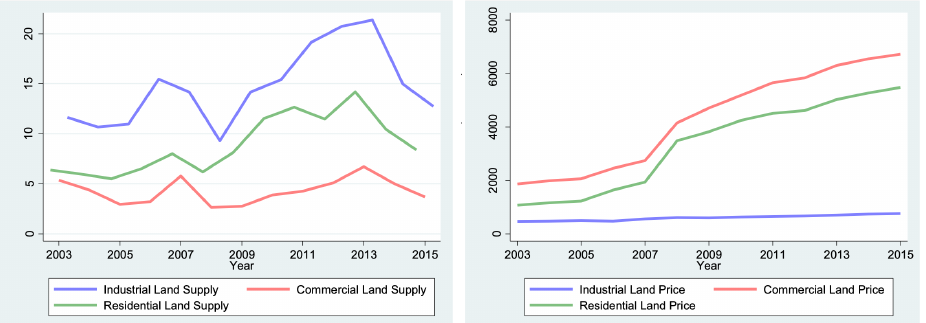
Figure 2. Land Supply ( left ) and land price ( right ) by land